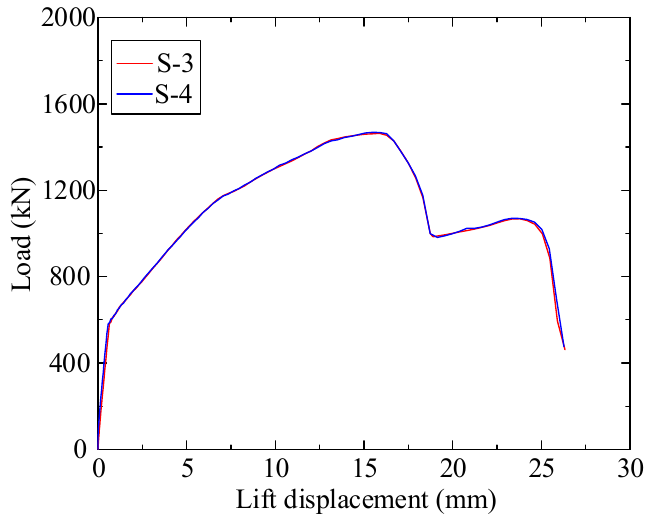
Figure 15. Load–lift displacement curves of S-3 and S-4.